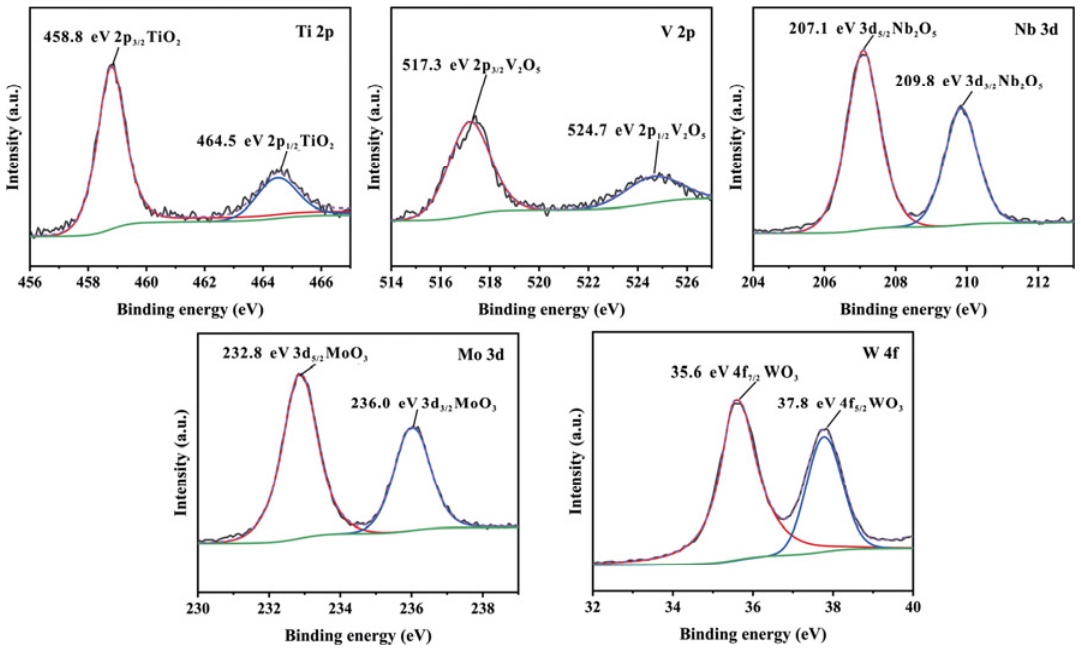
Fig. 14 XPS spectra of tribofilms on worn surfaces of high-entropy (TiVNbMoW)C 4.375 after sliding at 800 ℃